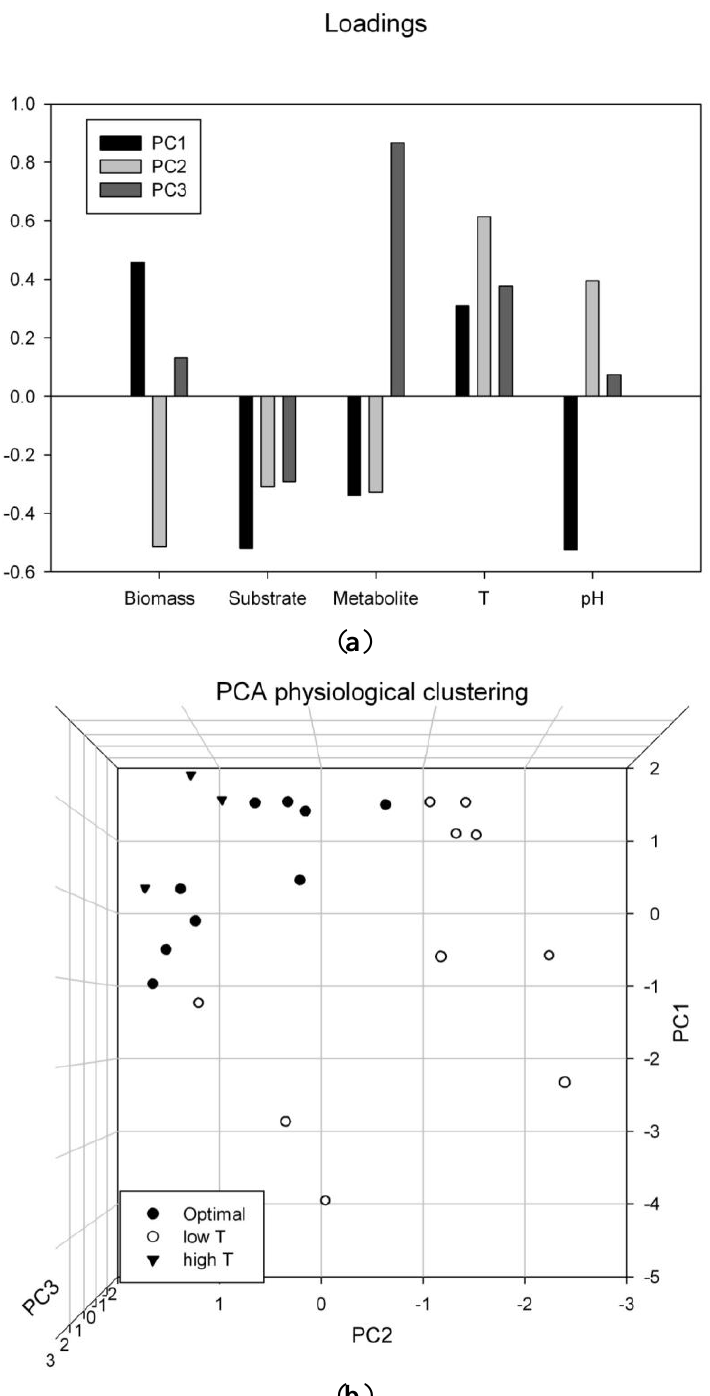
Figure 4. The results of the principal component analysis with the chosen standardized off-line variables performing on all experimental data along the ramps. ( a ) The loadings of the chosen variables on the principal components. It can be seen which variable has significantly greater loading on which principal component. ( b ) In order to obtain clustering by the physiological differences reasoned by the process parameter temperature, the first principal component vs . the second principal component is depicted. The variance along the third principal component can help with the clustering based on the pH values (data not